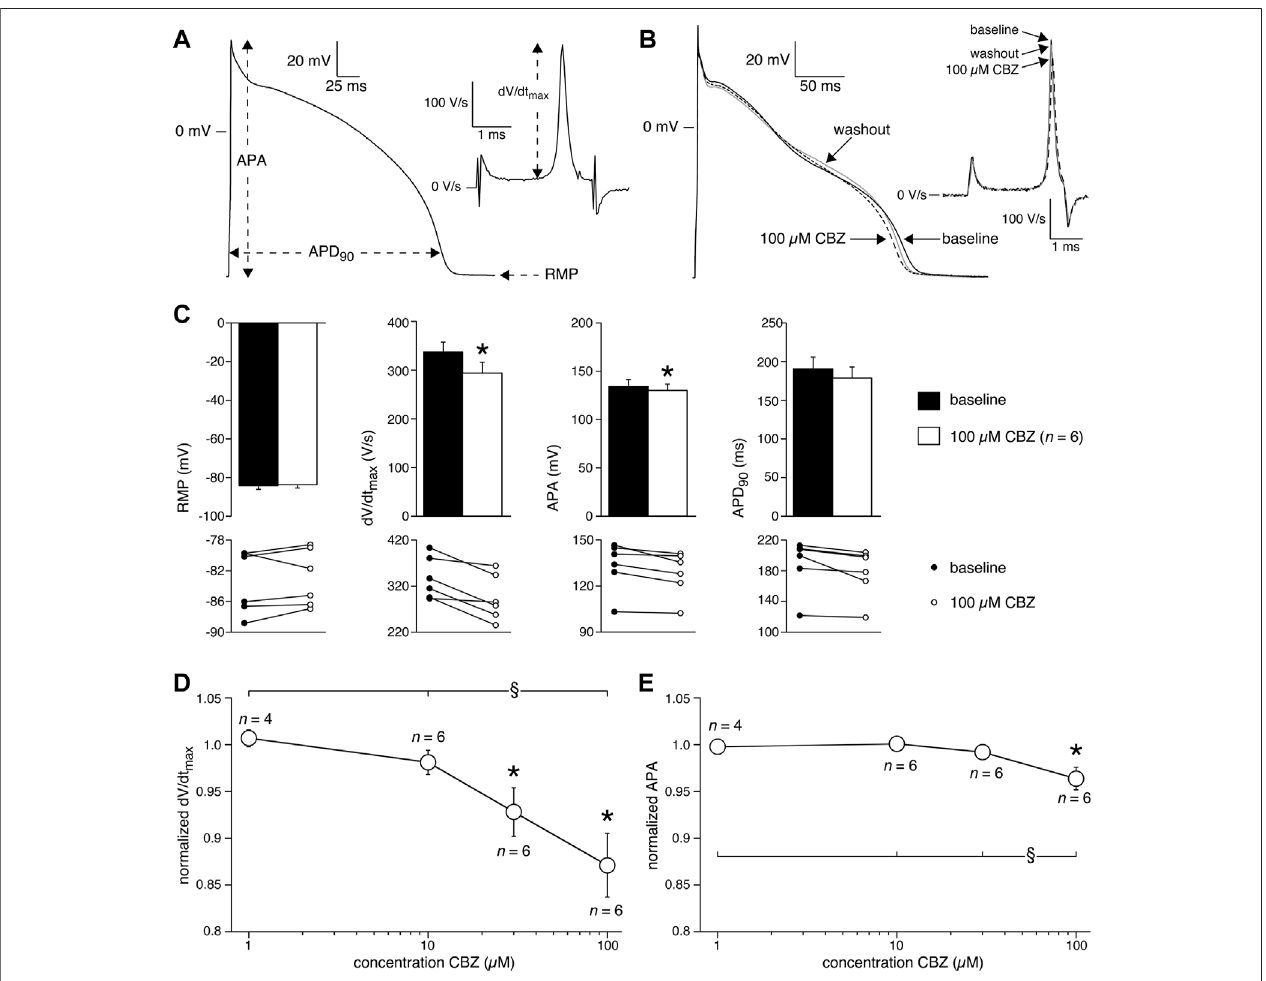
FIGURE 1 | Carbamazepine (CBZ) reduces the action potential (AP) upstroke velocity and AP amplitude of rabbit ventricular cardiomyocytes. (A) AP recording illustrating the analyzed AP parameters. Inset: time derivative (dV/dt) of the AP upstroke on an expanded time scale. RMP, resting membrane potential; APA, AP amplitude; APD 90 , AP duration at 90% of repolarization; dV/dt max , maximal AP upstroke velocity. (B) Superimposed representative APs at 1 Hz under baseline conditions, in presence of 100 µM CBZ, and upon washout of the drug. Inset: time derivatives of the AP upstrokes. (C) Average AP characteristics at 1 Hz (top panels)andindividual(paired)datapoints(bottompanels).* p < 0.05CBZversusbaseline(One-WayRMANOVA). (D,E) AveragenormalizeddV/dt max (D) andAPA (E) at 1 Hzinresponseto1,10,30,and100